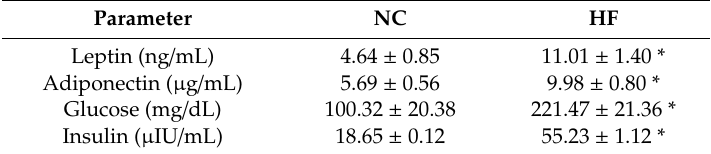
Table 3. Plasma adipokine, glucose, and insulin levels after 10 weeks of